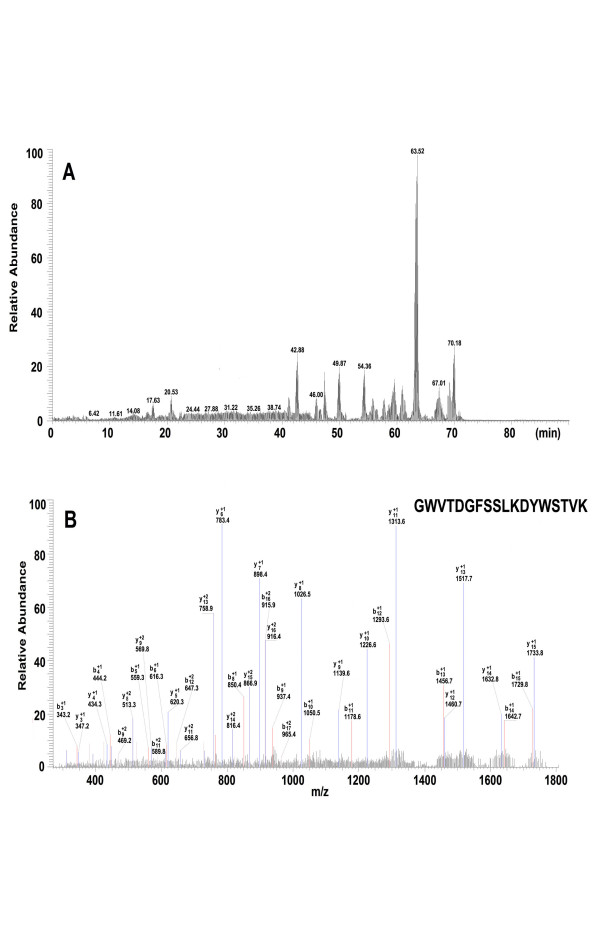
Results of the identification of protein (8697 Da) by LC-MS/MS. (A) Chromatogram of peptide mixture. (B) MS/MS spectrum of one peptide.